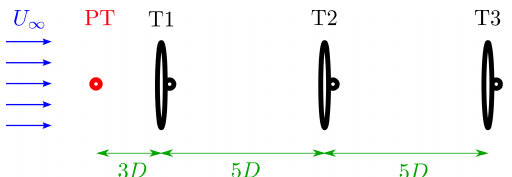
Figure 5. A schematic top view of the wind farm setup in the wind tunnel. The pitot tube (PT), which measures the inflow velocity, is located two rotor diameters D in front of turbine 1 (T1). The spacing between the turbines is 5 D and the wind flows from left to